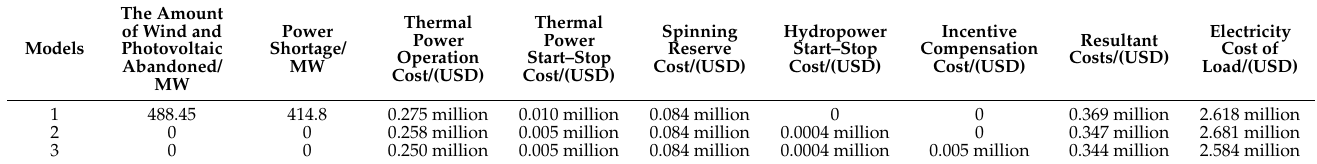
Table 3. System operating costs in the three